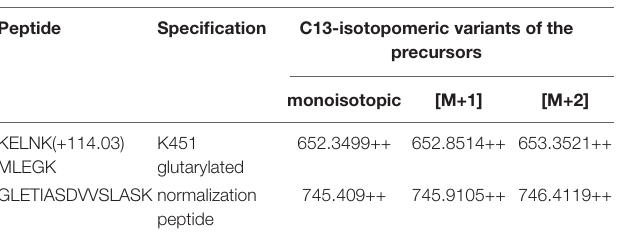
TABLE 1 | Characterization of ODP2 peptides.